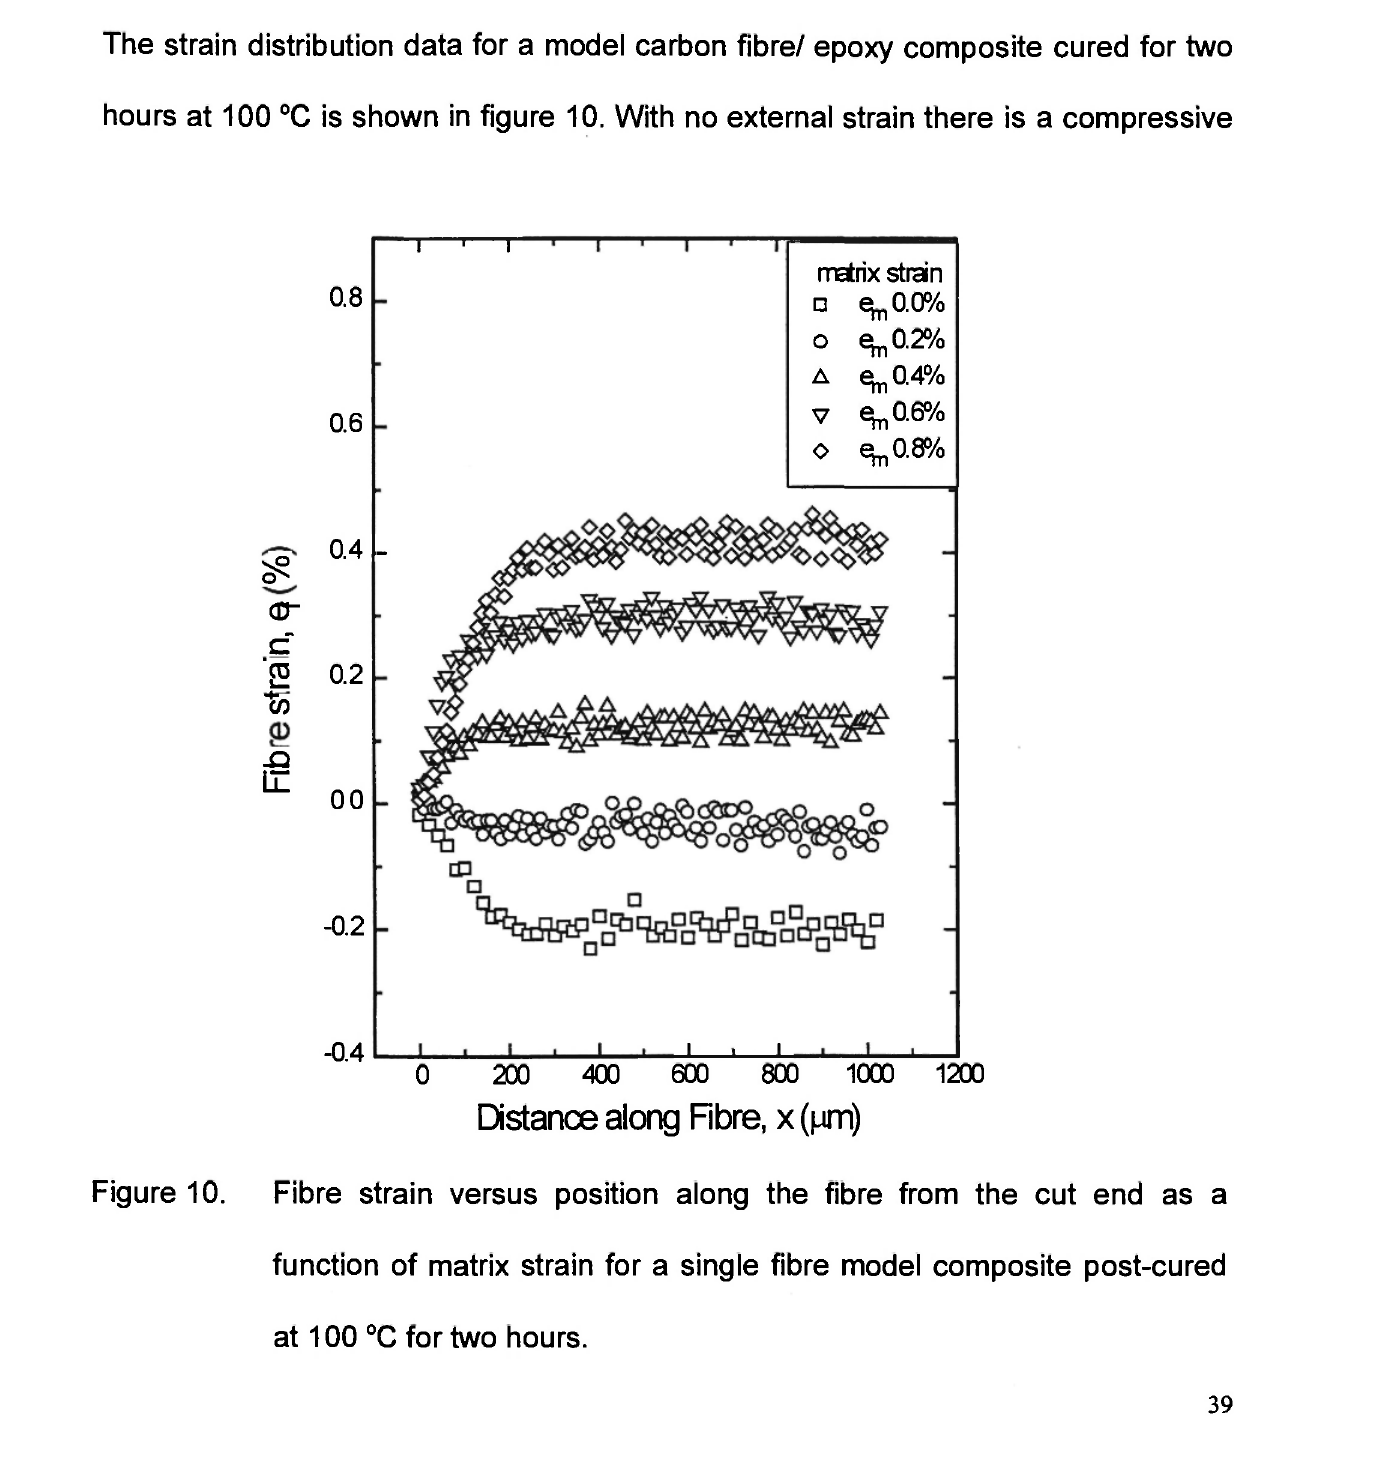
Figure 10. Fibre strain versus position along the fibre from the cut end as a function of matrix strain for a single fibre model composite post-cured at 100 °C for two